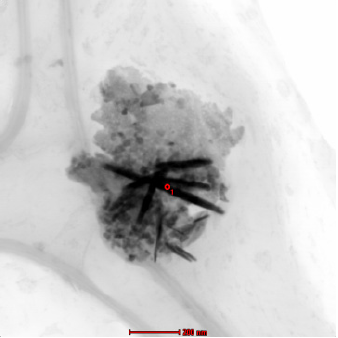
Figure 1. Transmission Electron Microscopy (TEM) image of flower-like ZnO